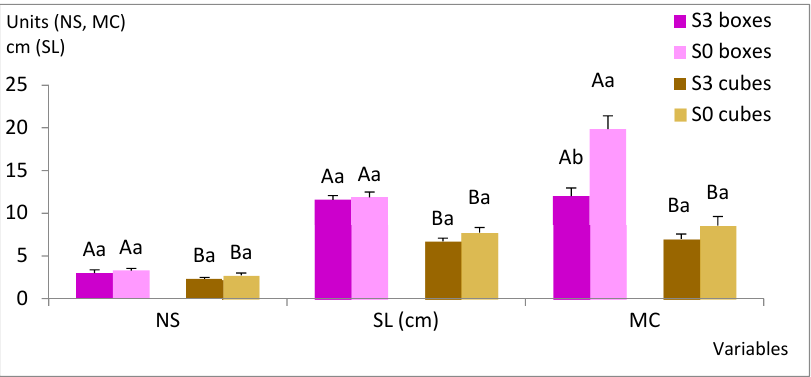
Figure 3. Effect of support material (rockwool and plastic boxes) and sucrose supplementation (S0 and S3, corresponding to 0 and 3% sucrose, respectively) on proliferation rates of willow shoots grown in continuous immersion bioreactors. Shoots were grown in MS medium with half-strength nitrates and 0.22 µM BA for 8 weeks. Values are presented as mean ± standard error (3 replicates with 20 explants each). For each variable, different uppercase letters indicate significant differences in relation to the support, and different lowercase letters indicate significant differences relative to the sucrose supplementation ( p < 0.05). Due to the significant interaction found in MC, Bonferroni’s adjustment was applied to detect simple main effects. NS, number of shoots; SL, length of the longest shoot; MC, multiplication